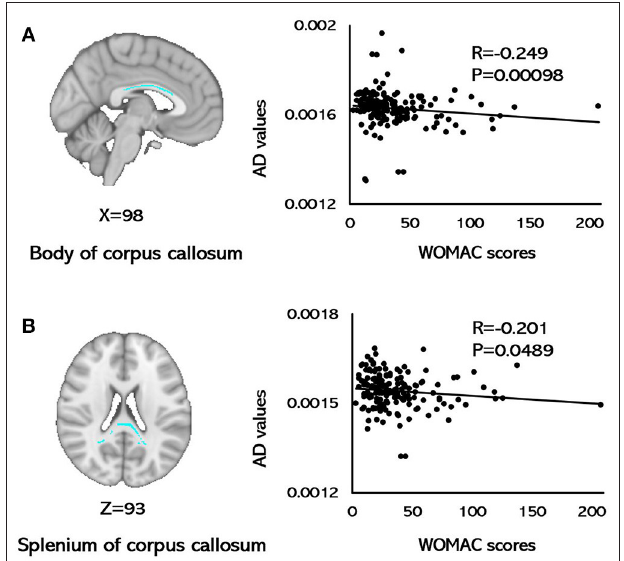
FIGURE 2 | Correlations between AD values and WOMAC scores. (A) A negative correlation was observed between AD values for the body of the corpus callosum and WOMAC scores. (B) A negative correlation was observed between the AD values for the splenium of the corpus callosum and WOMAC scores ( p < 0.05, FDR corrected). AD, axial diffusivity; FDR, false discovery rates; WOMAC, Western Ontario and McMaster Universities Osteoarthritis